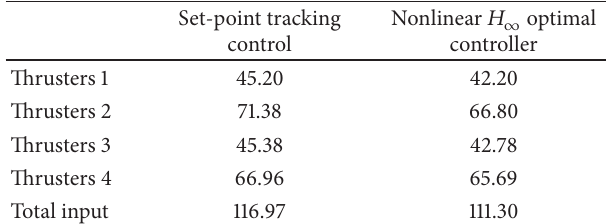
Figure 3: Three-dimensional view for conventional region tracking control. Table 1: Simulation result: vehicle forces for four vertical thrusters